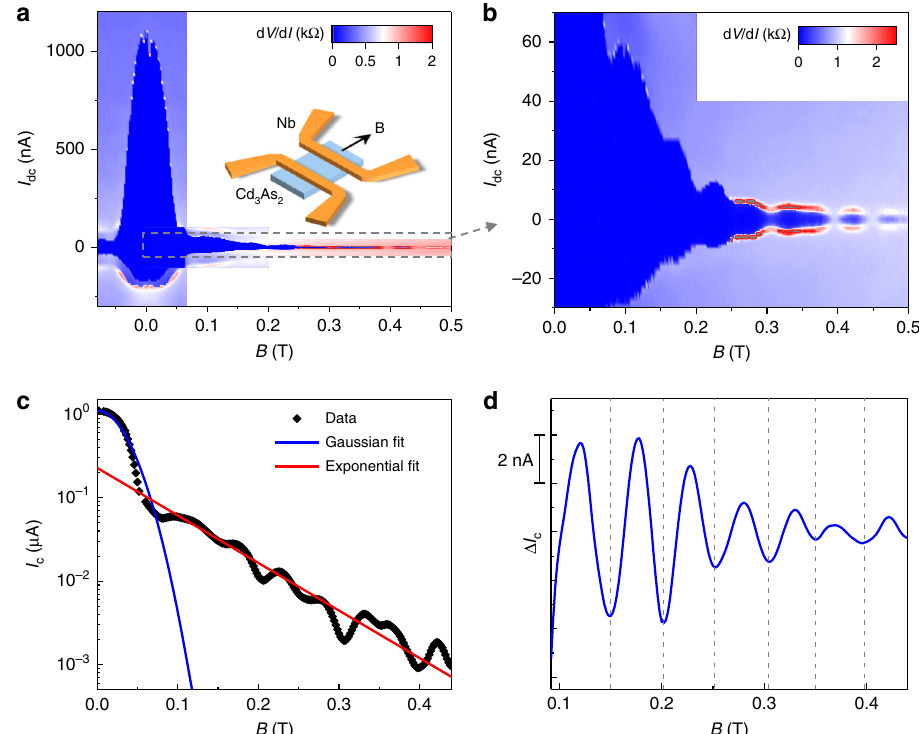
Fig. 2 The supercurrent oscillations under parallel magnetic fi eld at V g = 0 V. a The d V /d I as a function of magnetic fi eld B and I dc . The I dc is swept from negative to positive. The applied excitation current I ac = 0.5 nA. Inset: Schematic of the magnetic fi eld direction on the junction. b The enlarged d V /d I map of the gray dotted box in a . Periodic supercurrent oscillations with multiple nodes are observed. c The magnetic fi eld dependence of I c with a semilog coordinate. The Gaussian fi tting (blue curve) well models the decay trend of I c at low B , and an exponential decay (red line) fi ts better the data for B > 0.1 T. d The extracted Δ I c by subtracting a smooth background as a function of B . A period of Δ B = 0.05 T is obtained from the